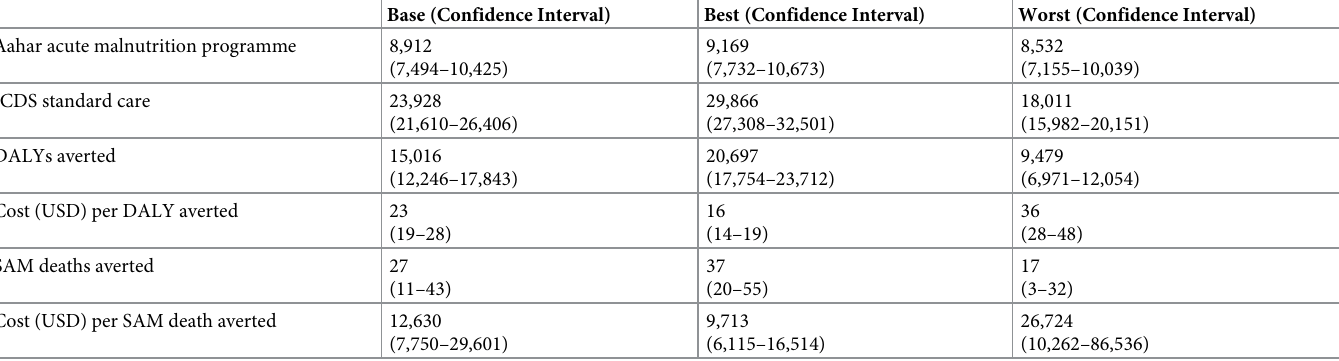
Table 3. Disability-Adjusted Life Years (DALYs), DALYs averted, and cost per DALY averted under different mortality scenarios (base, best and worst) for the community based treatment and prevention programme versus ICDS standard care